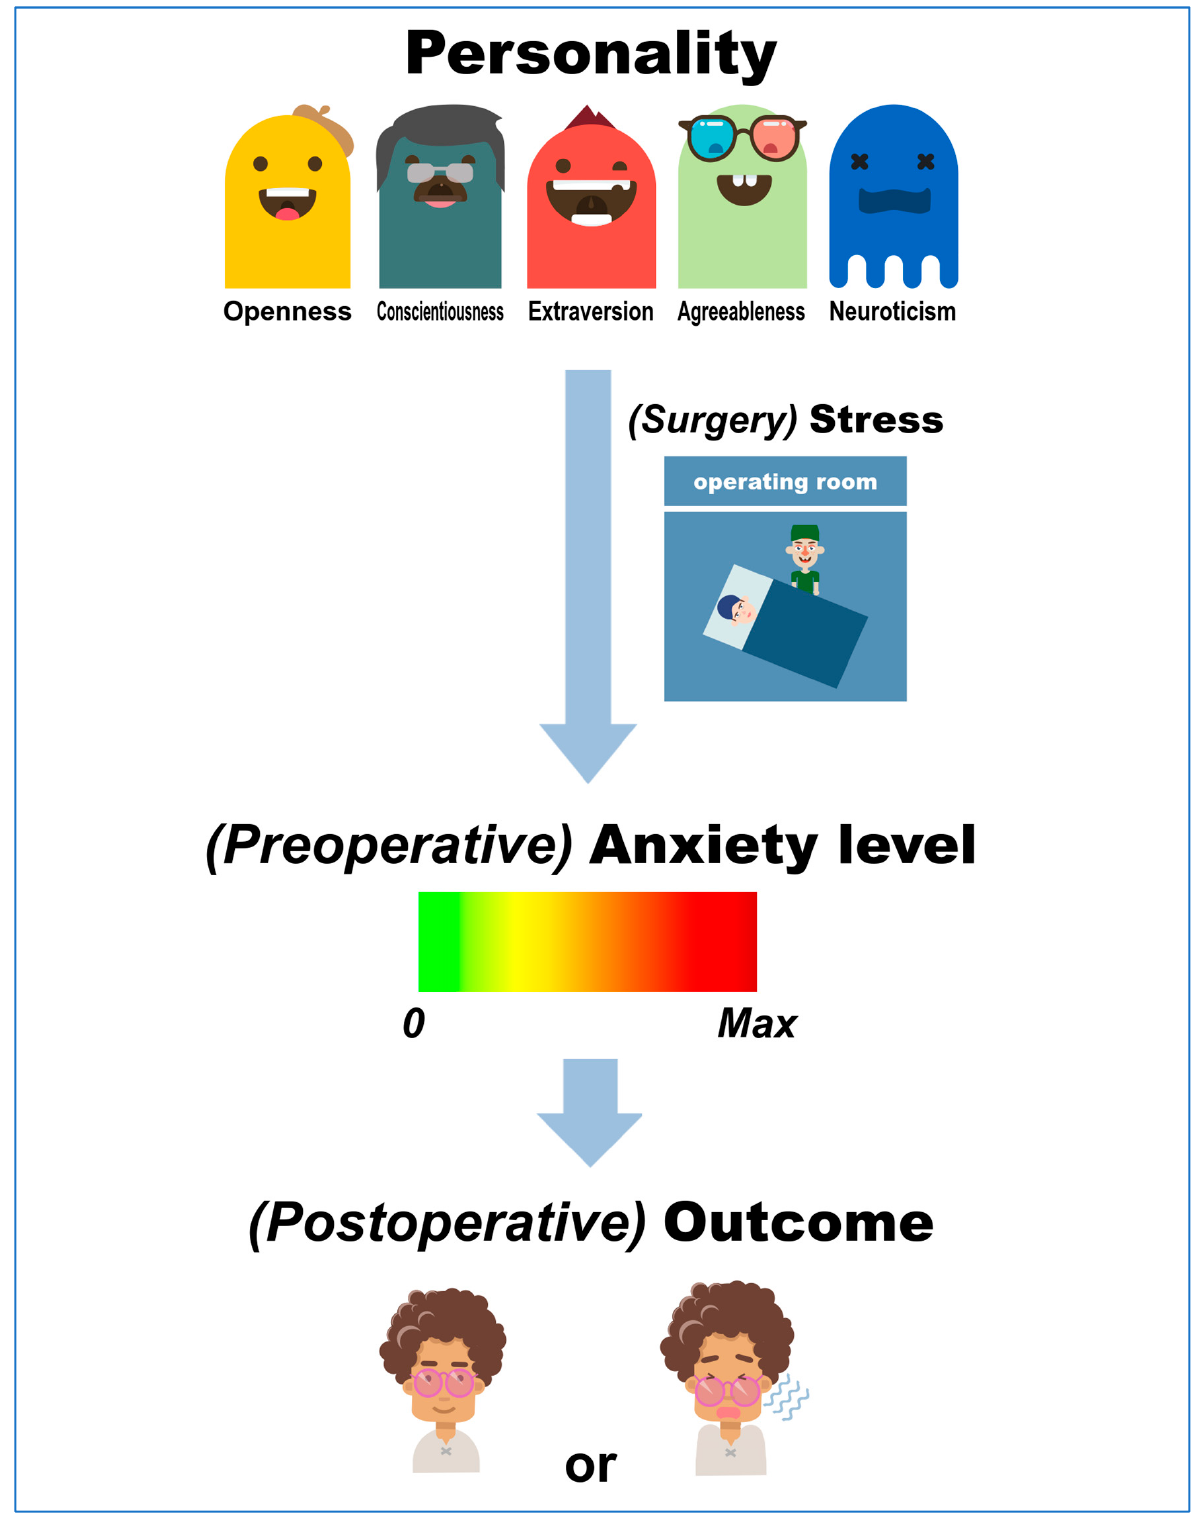
Figure 2. The mechanism underlying the relationships between personality traits, preoperative anxiety, and postoperative outcomes. The Big Five framework was used to describe personality.